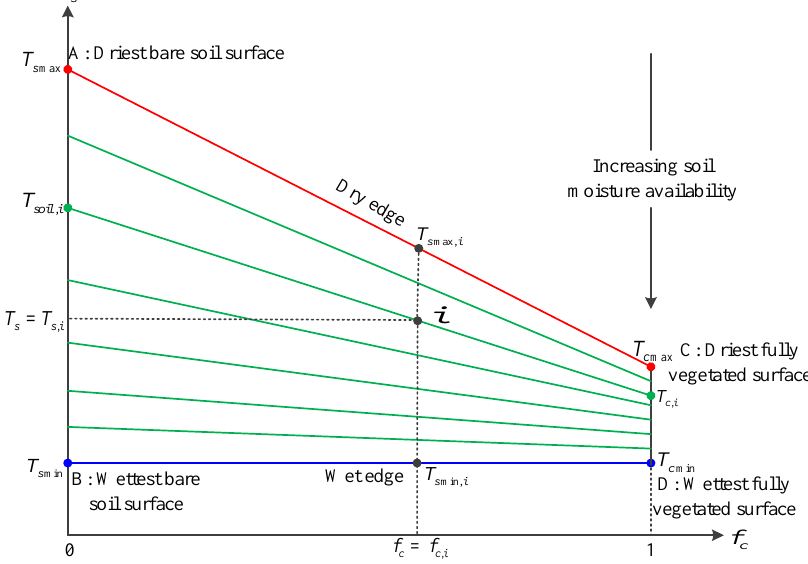
Figure 2. A conceptual sketch of the theoretical trapezoid T s − f c feature space. Upper red line represents the dry edge under extreme water stressed conditions. Horizontal blue lines represents the wet edge under maximum soil moisture availability. Slanting green lines enclosed by the boundaries represent superimposed isopleths of soil moisture availability. Point A ( f c = 0, T s = T smax ) represents the driest bare soil surface with the Priestley-Taylor parameter ∅ equal to zero, point B ( f c = 0, T s = T smin ) represents the wettest bare soil surface with ∅ equal to 1.26, point C ( f c = 1, T s = T cmax ) represents the driest fully vegetated surface with the Priestley-Taylor parameter ∅ equal to zero, and point D ( f c = 1, T s = T cmin ) represents the wettest fully vegetated surface with the Priestley-Taylor parameter ∅ equal to